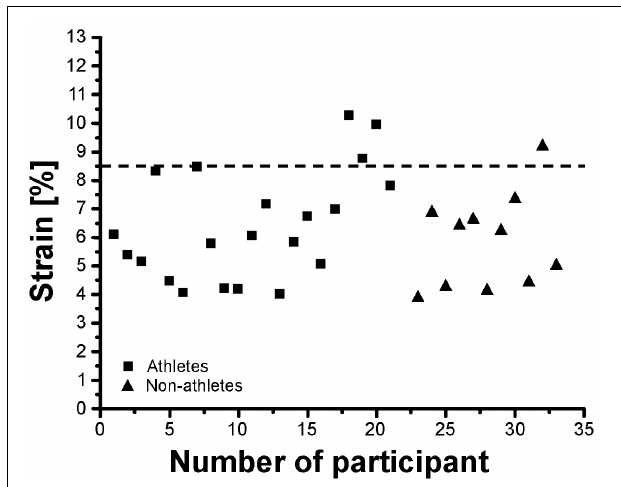
FIGURE 3 | Individual Achilles tendon strain values during maximum isometric contractions in the investigated preadolescent athletes and non-athletes.